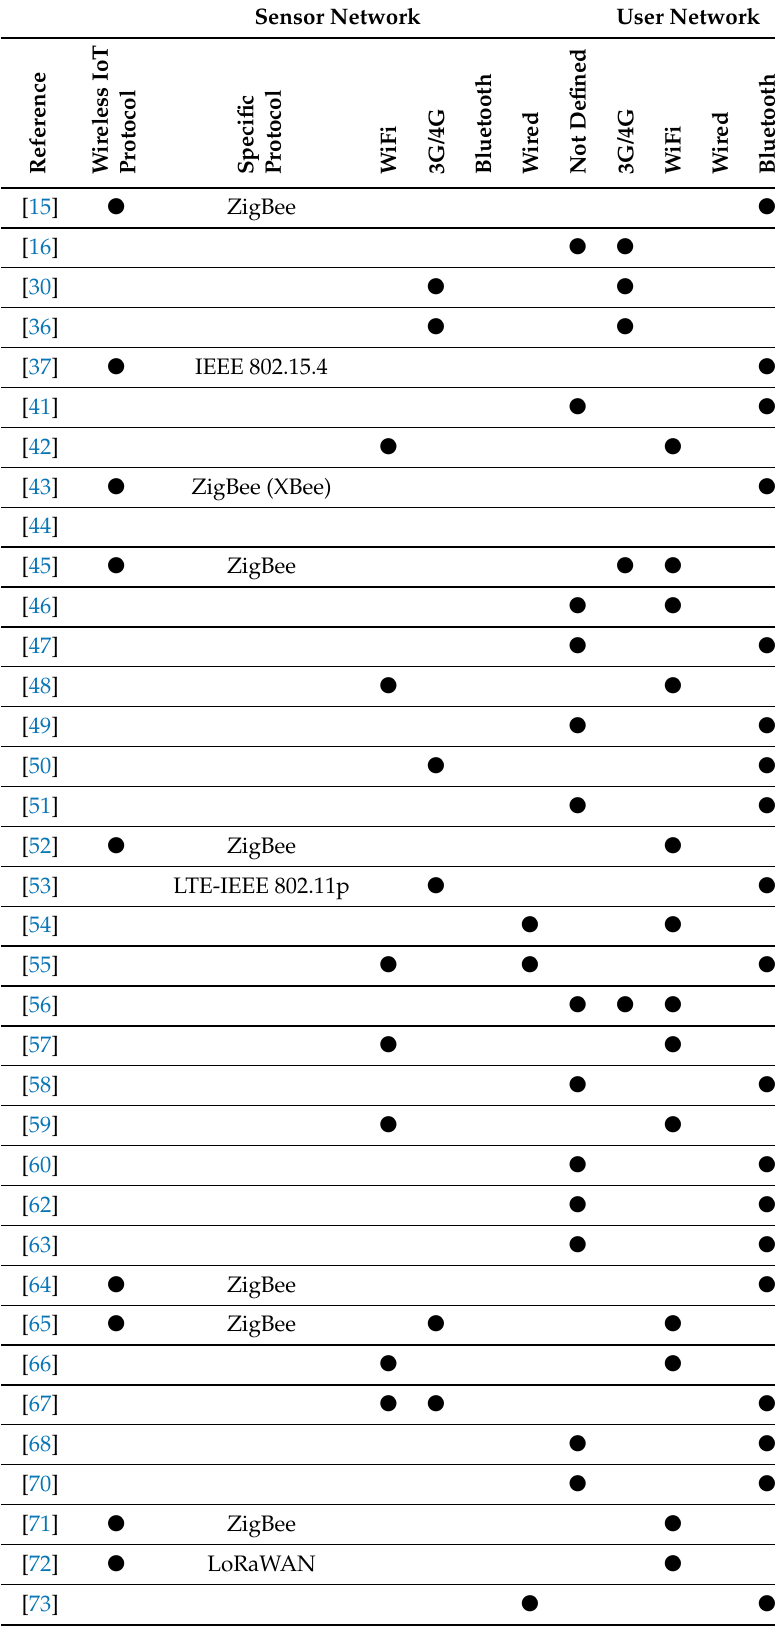
Table 5. Sensor network and user network